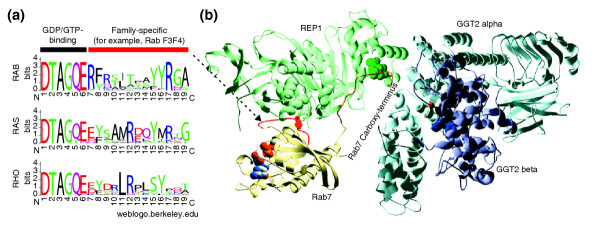
Determinants of GGT2 prenylation. (a) Sequence logos [74] of Ras superfamily members around part of the Rab-REP interaction site (colored red in the otherwise yellow GTPase structure). (b) Structural model of the Rab-REP-GGT2 prenylation complex based on PDB entries 1LTX [77] and 1VG0 [4]. REP1 (green) has a prenyl-binding pocket which is proposed to be involved in the dual geranylgeranylation mechanism (bound geranylgeranyl is shown in green). However, the catalytic attachment to the substrate cysteines takes place in the center of the GGT2 alpha-beta complex (light and dark blue) where the prenylpyrophosphate that will be transferred is also bound (blue space-filling representation, zinc in red). The structure was visualized using Swiss-Pdb Viewer [59].